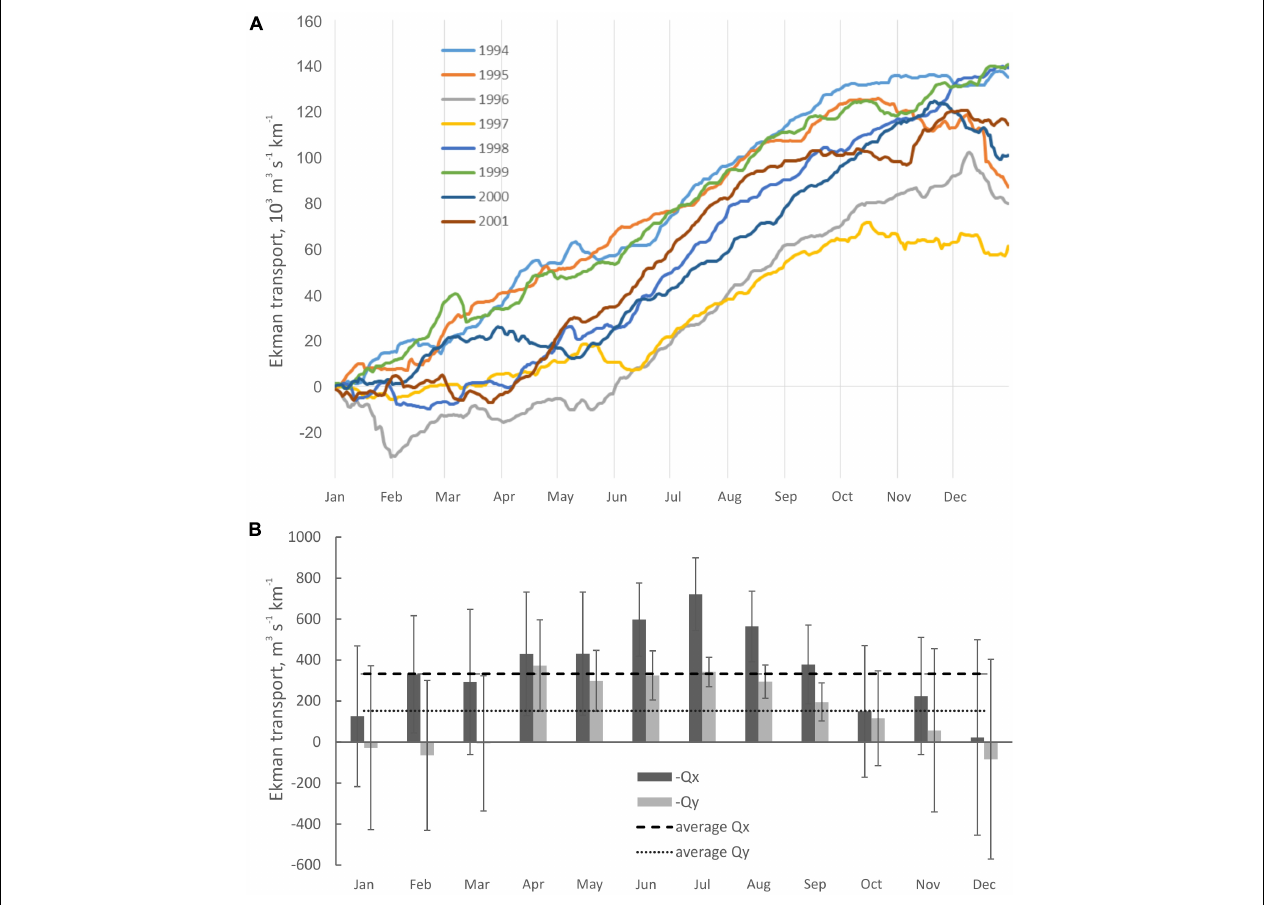
FIGURE 2 | (A) Cumulative annual upwelling index (CUI, Q x ) (m 3 s − 1 km − 1 ), 1994–2001; (B) Monthly average Ekman transport along the western coast (Q x ), and southern coasts (Q y ) calculated from the wind stress during 1989–2009 (lower panel). Values converted to positive, bars = SE. Above average positive values of Qx and Qy indicate significant upwelling-favorable conditions (monthly means 1989–2009: Qx = 356, Qy = 152 m 3 s − 1 km − 1